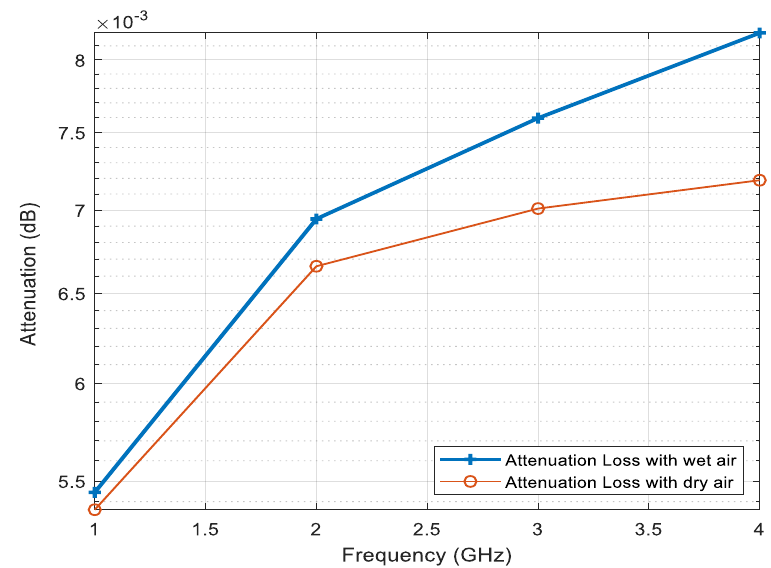
Figure 9. Attenuation loss plot versus frequency of wet and dry air.